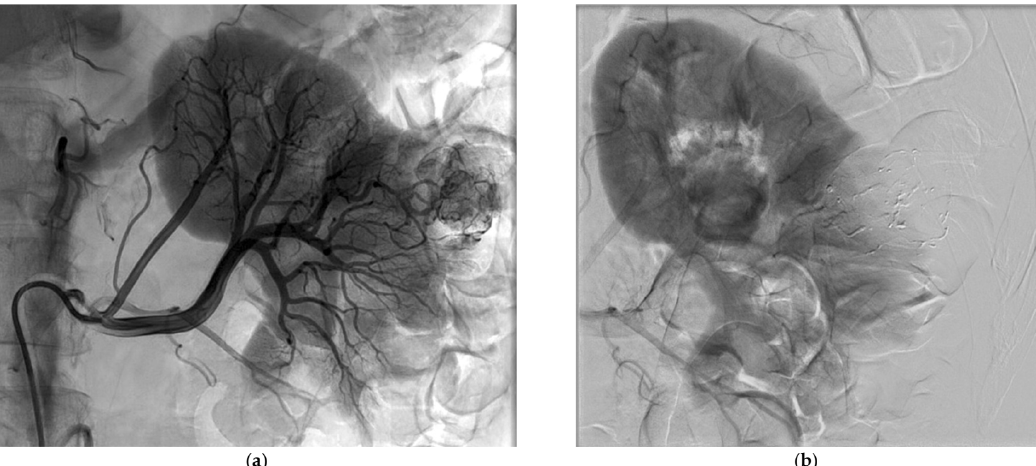
Figure 1. Selective arterial embolization (SAE) procedure using NBCA/Lipiodol ® mixture performed before percutaneous cryoablation of a renal cell carcinoma of the left kidney. ( a ) Angiogram showed hypervascularization of the renal malignancy with one feeding artery. ( b ) Control angiogram after SAE using NBCA/Lipiodol ® mixture (1/5 ratio) showing the complete occlusion of the tumor vessels and devascularization of the tumor whereas the surrounding healthy tissue was spared.